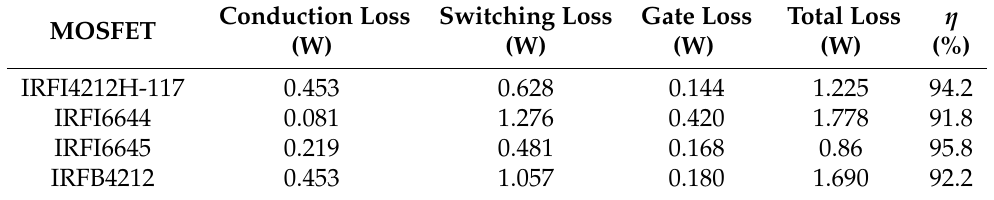
Table 5. Loss components and efficiency of the various switching MOSFETs